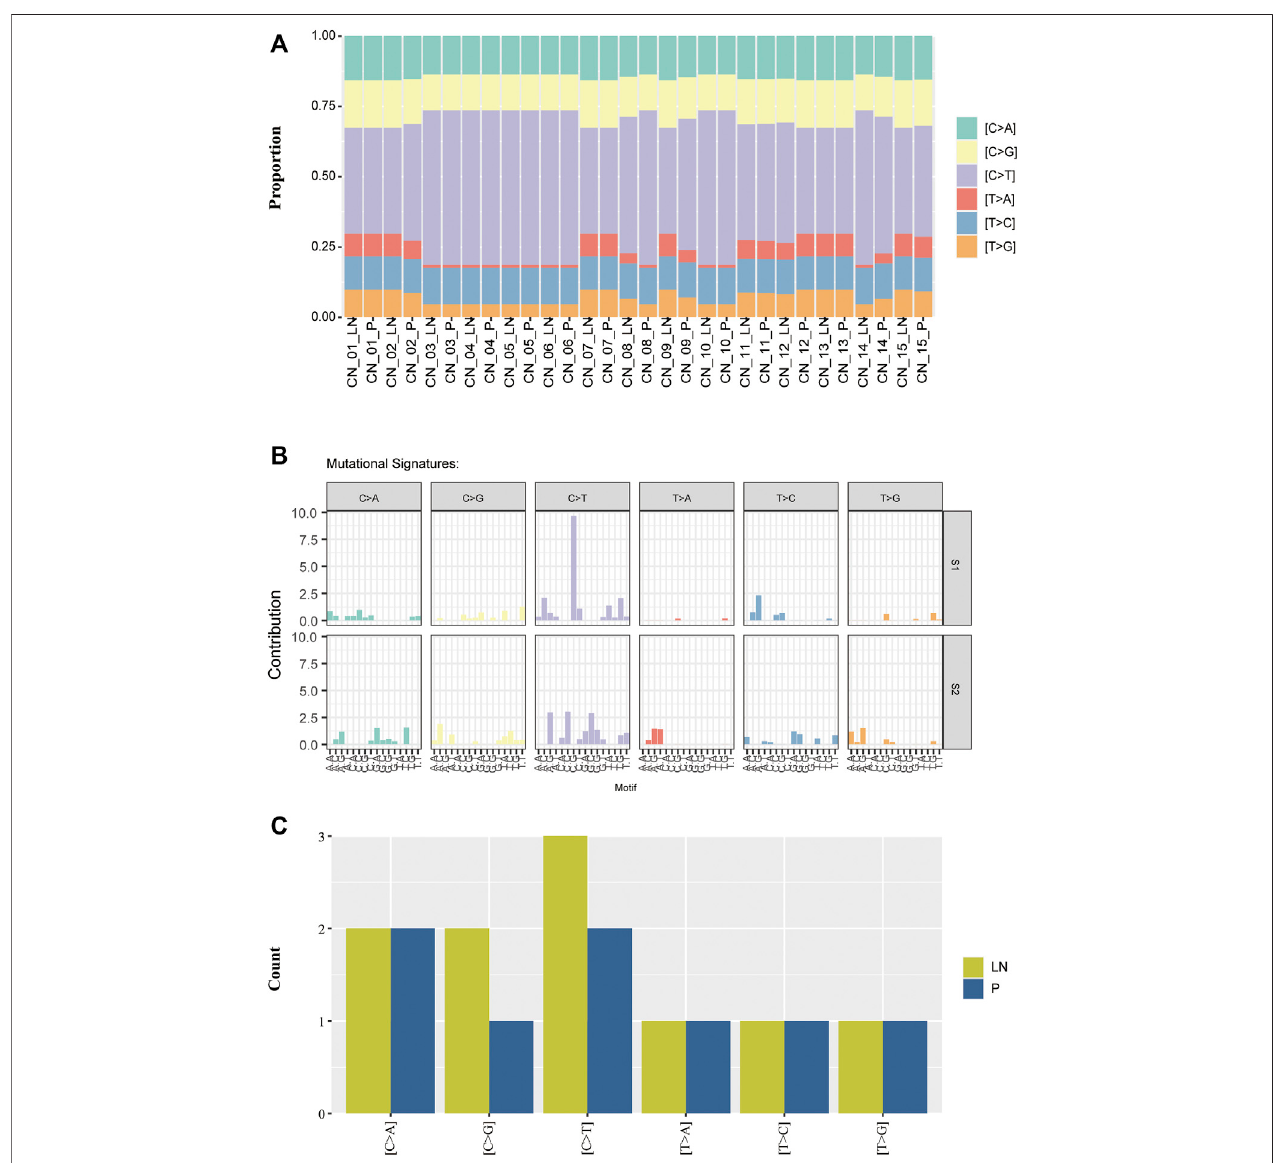
FIGURE 3 | The distribution of mutational signatures of the NSCLC paired samples. (A) Comparison of mutational signatures between primary and lymph nodes metastatic samples. (B) Two distant mutational signatures were identi fi ed by the NMF analysis of the matrix of mutational proportion across tumors from primary and metastatic lesions. (C) Comparison of mutational signatures of the private alterations between primary and lymph nodes metastatic samples.